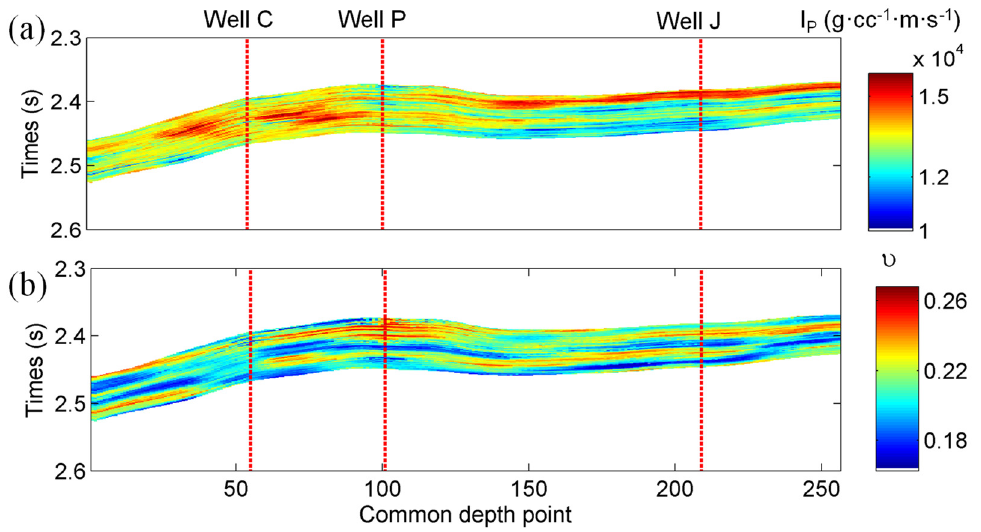
Figure 17. 2-D seismic profiles of P-wave impedance ( a ) and Poisson’s ratio ( b ) corresponding to a second survey.